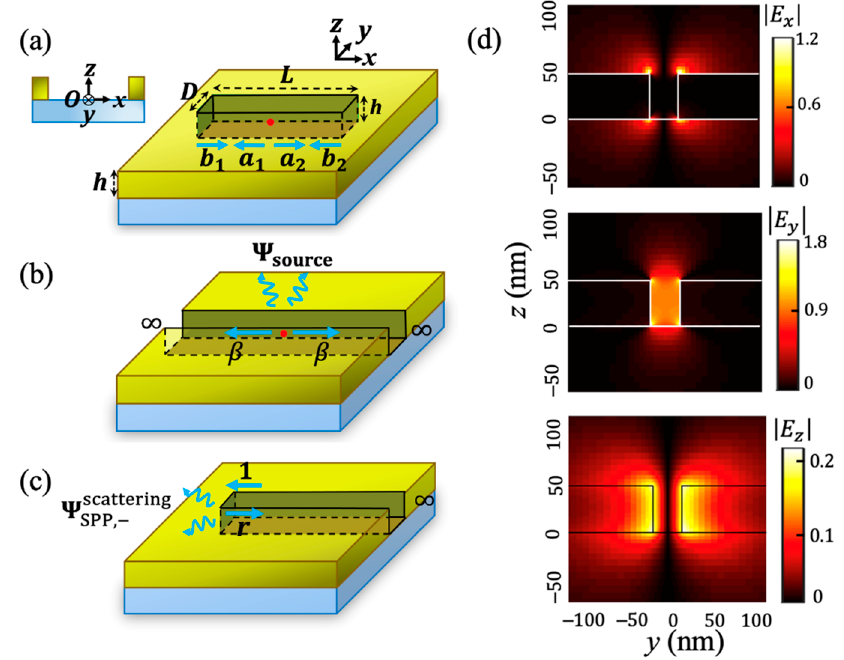
Figure 1. ( a ) Schematic diagram of the rectangular-aperture nanoantenna and the unknown SPP coefficients a 1 , a 2 , b 1 and b 2 in the SPP model. ( b , c ) Definitions of coefficients β , r and electromagnetic fields Ψ source and Ψ scattering used in the SPP model. ( d ) Distribution of the electric-field components (| E x |, | E y |, | E z |) of the fundamental SPP mode on the transversal y – z plane. The y component of the SPP electric field E y is normalized to be 1 at ( y , z ) = (0, h /2). The superimposed solid lines represent the boundaries of the aperture. The results are calculated with the full-wave a-FMM for D = 30 nm and h = 50 nm at wavelength λ = 1 μm .